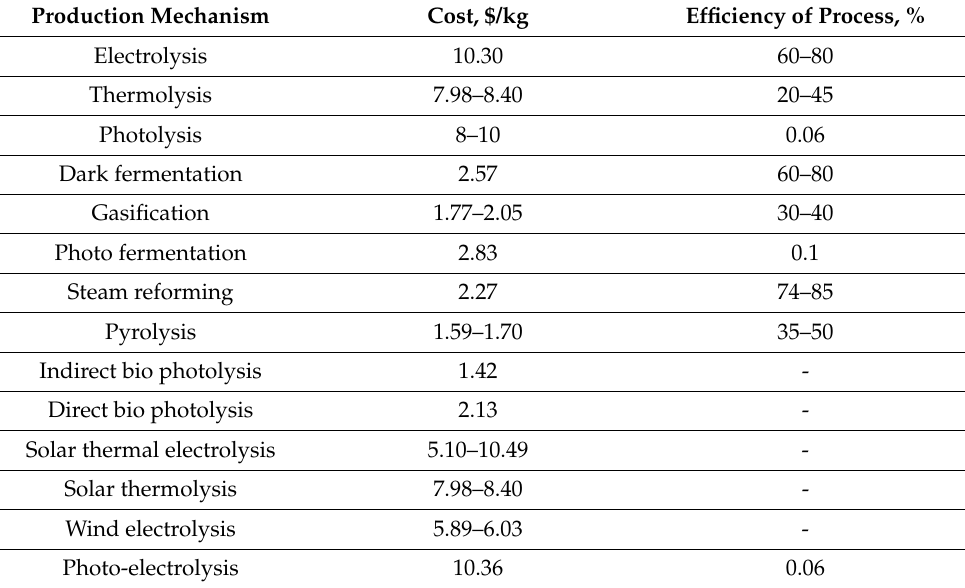
Table 3. Selected methods of hydrogen production with their cost and production efficiencies refs.